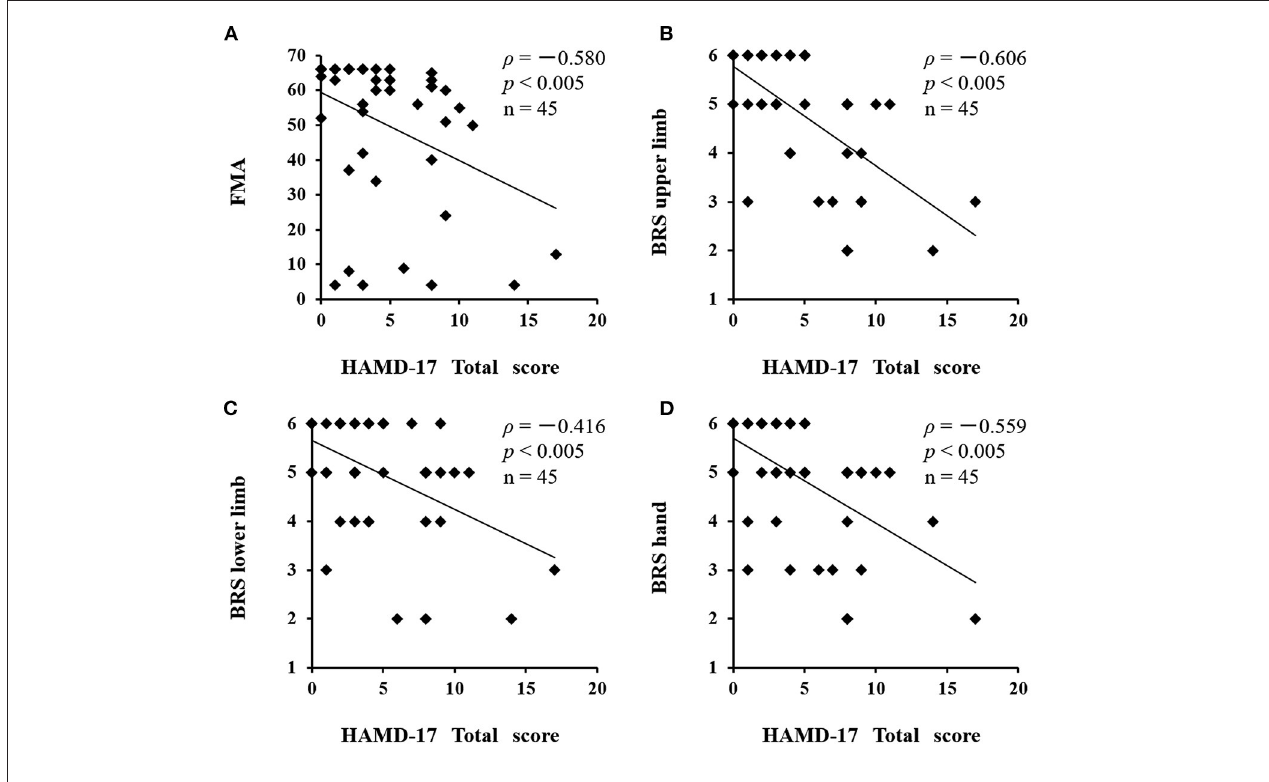
FIGURE 6 | Correlation between HAMD17 total scores and severity of paralysis after stroke. A negative correlation was found between the total scores of the HAMD17 and the FMA and BRS values. (A) HAMD17: FMA, ρ = − 0.580, P < 0.005; (B) HAMD17: BRS upper limb, ρ = − 0.606, P < 0.005; (C) HAMD17: BRS lower limb, ρ = − 0.416, P < 0.005; (D) HAMD17: BRS hand, ρ = − 0.559, P < 0.005). HAMD17, The 17-item Hamilton Rating Scale for Depression; FMA, Fugl-Meyer Assessment; BRS, Bruunstrom Recovery